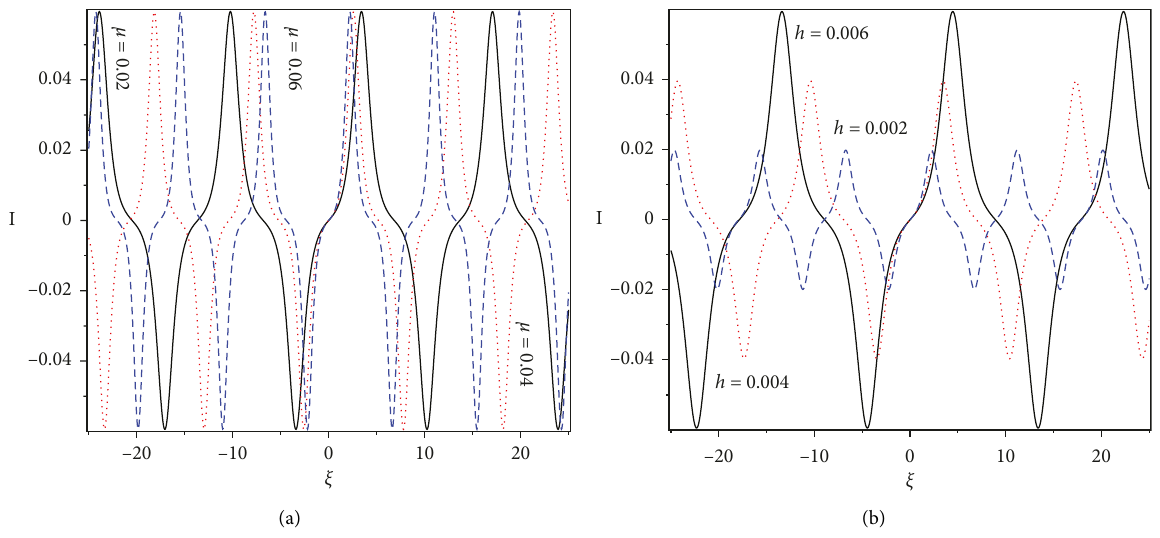
Figure 9: Parameters affecting the superwave solution (39): (a) changes in μ for R 0 . 00002 , and σ